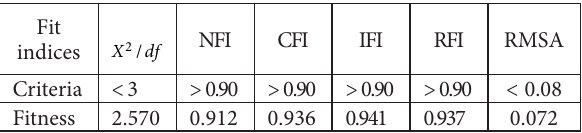
Table 4. Goodness-of-fit of